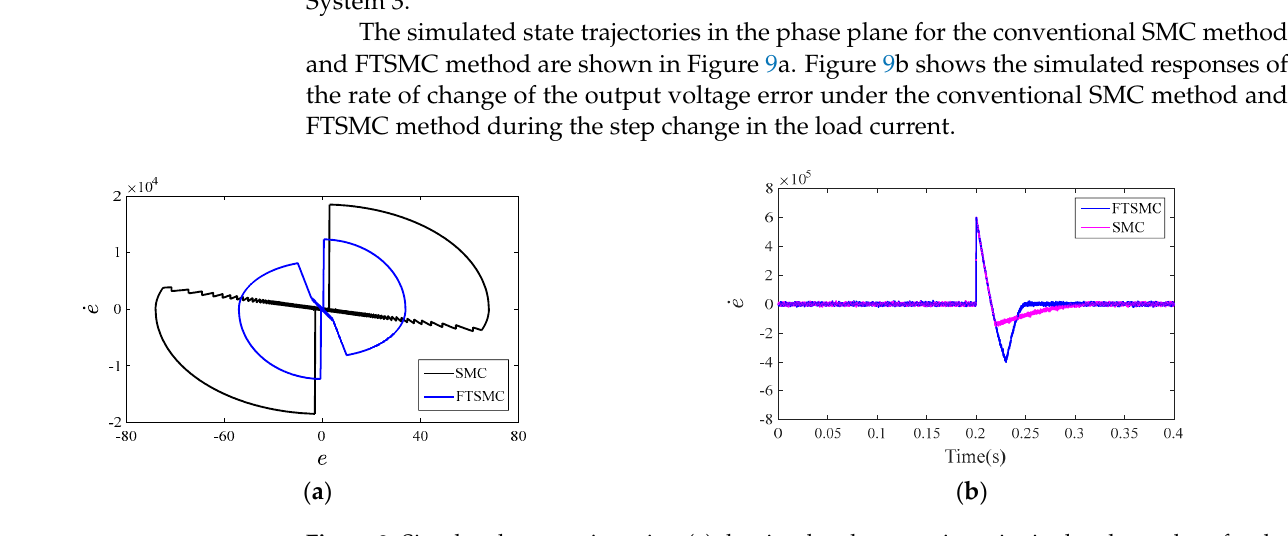
Figure 9. Simulated state trajectories: ( a ) the simulated state trajectories in the phase plane for the conventional SMC method and FTSMC method and ( b ) simulated responses of the rate of change of the output voltage error under the two methods.